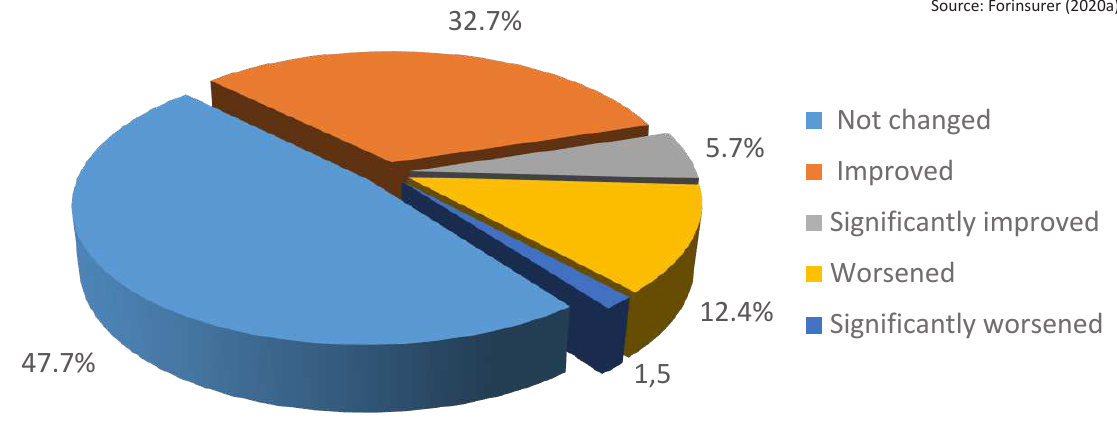
Figure 6. Respondents’ answers for the question “How the situation in your company has